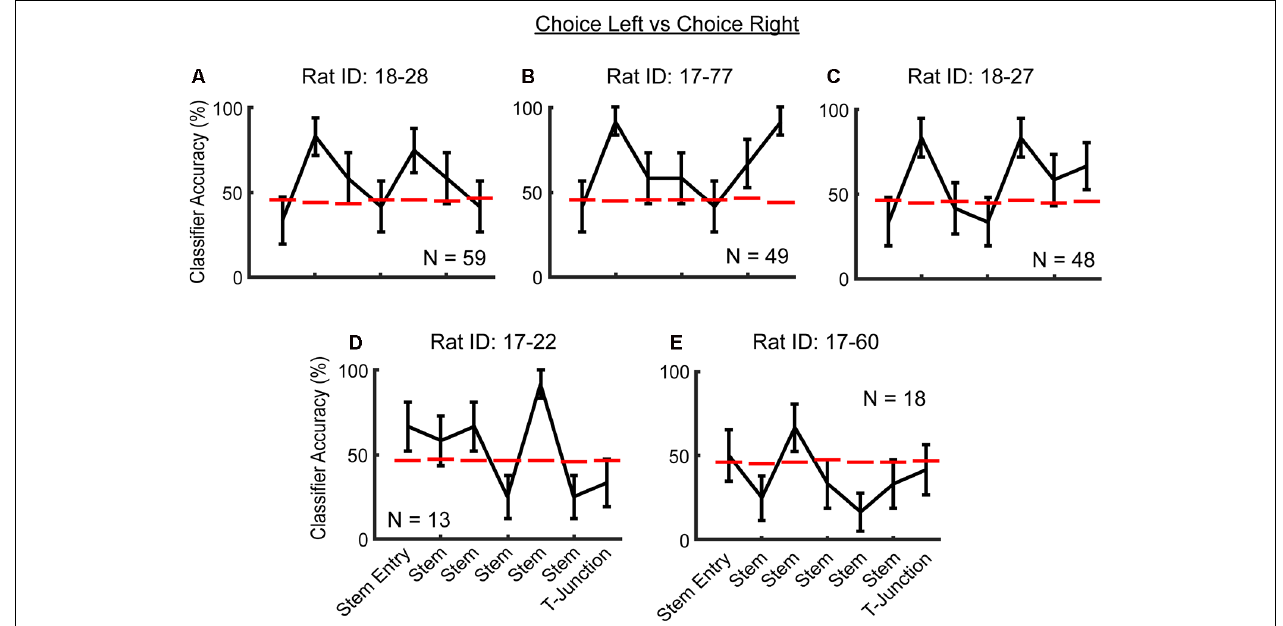
FIGURE 4 | Consistency in future action prediction of mPFC ensembles across rats. (A–C) Notice the peak in classification accuracy in the second stem bin. Additionally, note that in rats (A–D) , there are peaks in classification accuracy that are well above chance threshold, before T-junction entry. Data are displayed as the mean ± standard deviation of classification accuracies for all trials. The dashed red line indicates a chance level distribution generated using 1,000 shuffled labels. Dashed magenta lines indicate a significant effect that does not survive a corrected alpha. (D–E) Rats with lower sample sizes of recorded neurons did not exhibit the effect at the second stem